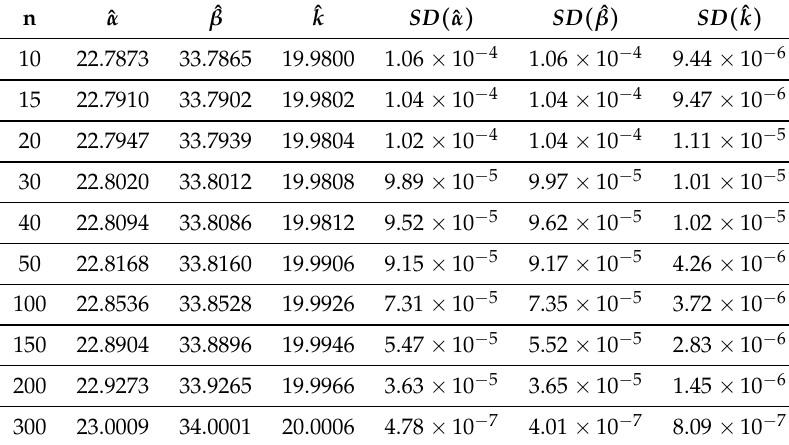
Table 1. Results of simulation with conjugate gradient method for m = 10,000 iterations, with α = 23, β = 34, k = 19, θ = 0.15.